Question: Reading the figure, is the described quantity rising or falling?
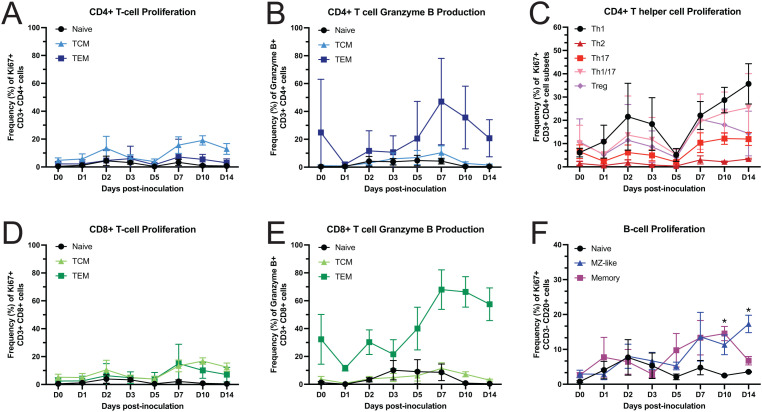
Answer: increasing